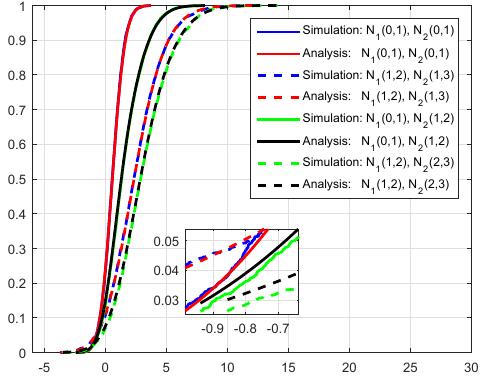
Figure 2. The CDF with varied parameters of